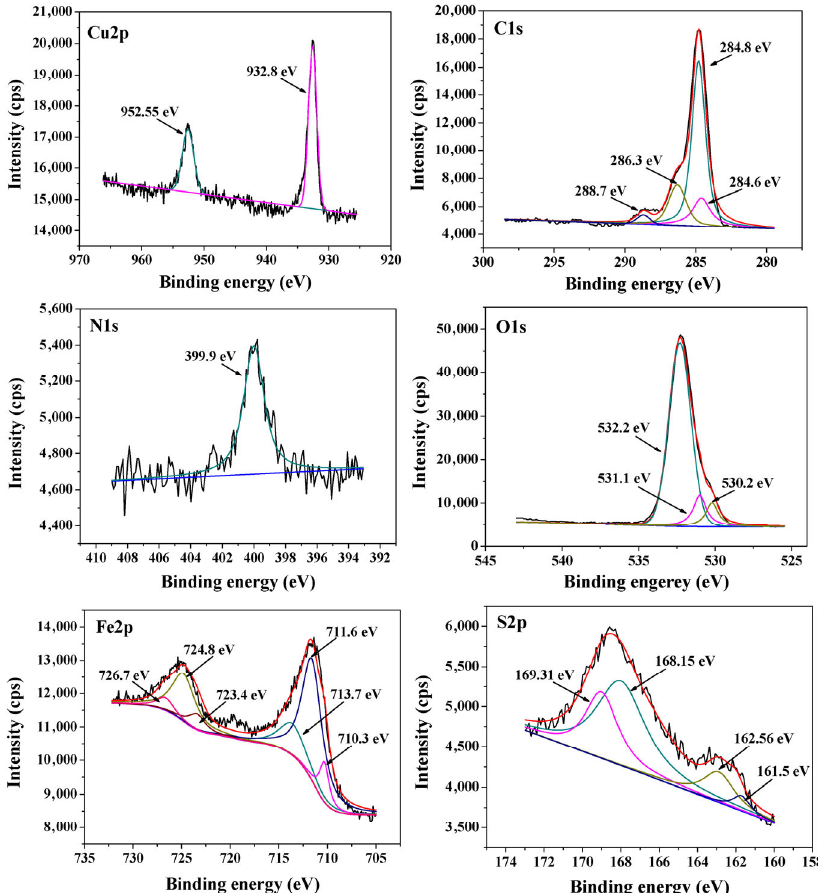
Fig. 10 XPS spectra of silicon wafer surfaces lubricated with distilled water containing 0.6% water-soluble Cu nanoparticles (load: 10 N; time: 5